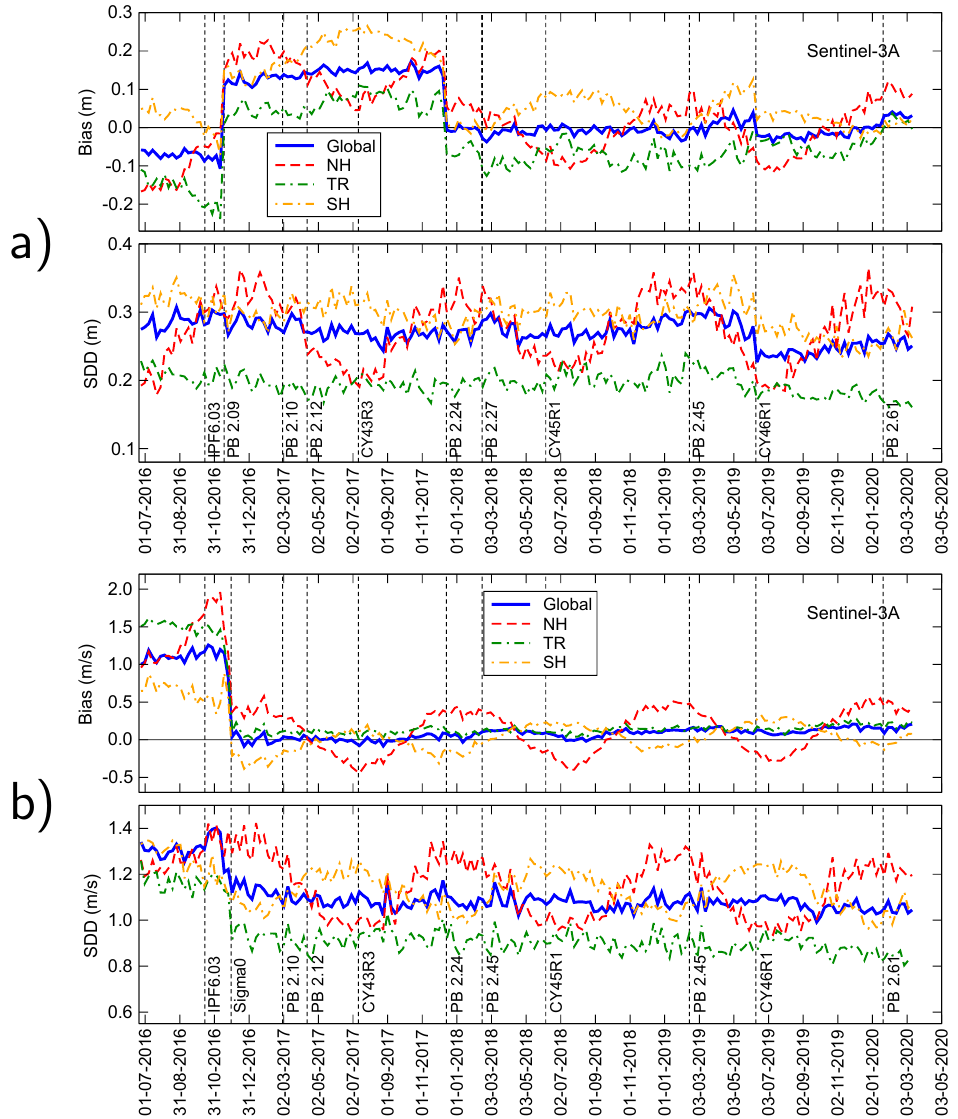
Figure 17. Time series showing evolution in S3A bias and SDD (Standard deviation of difference) with respect to a model, as different PBs are implemented in the NRT processing or changes made in the ECMWF model (indicated by ‘CY’). ( a ) Wave height ( b ) Wind speed. Data are plotted with a 7-day running mean, ‘NH’ is the northern hemisphere, north of 20 ◦ N; ‘SH’ is south of 20 ◦ S and ‘TR’ the tropical band in